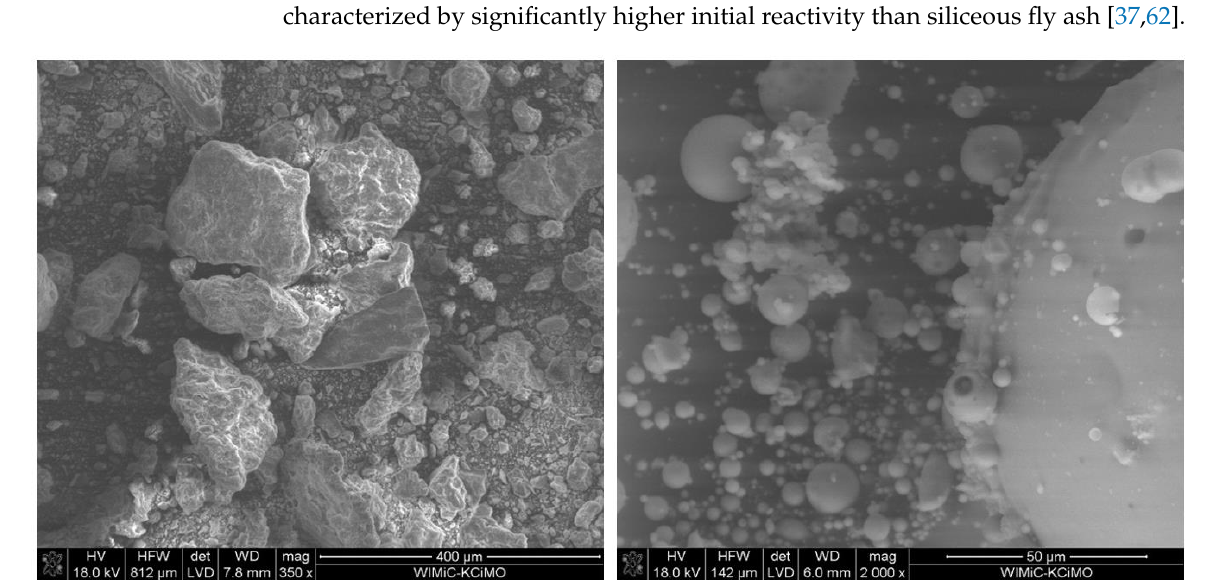
Figure 1. SEM images of grain morphology of MAFBC fly ash ( left ; mag. 350×) and siliceous fly ash ( right , mag. 2000×). To ensure comparable workability and air content in fresh mortars, CHRYSO ® Optima 185 superplasticizer was used. Additionally, to control crack propagation and geometric invariability in later stages, Astra Polyex Mesh 2000 ® high-modulus 12 mm long polypropylene fibers (dosage: 2 vol%) were used in the samples intended to study self-sealing effects. The formulations of the designed mortars are shown in Table 3. Mp(F/S)_q denotes the mortar with p % replacement of cement with MAFBC fly ash ( F ) or siliceous fly ash ( S ) and w/b = q